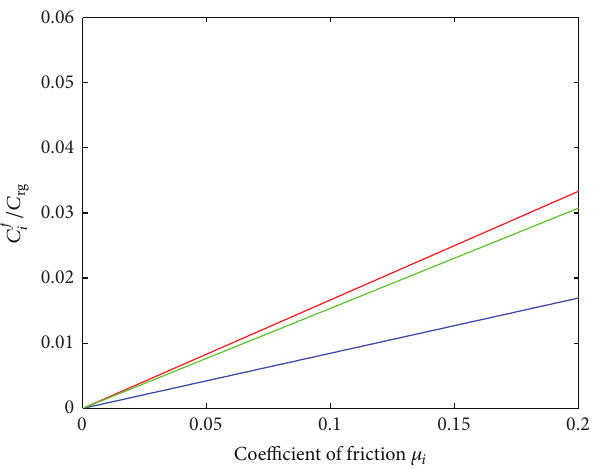
Figure 11: Friction torque ratio 𝐶 𝑖 /𝐶 friction 𝜇 𝑖 with 𝑖 = ( ax / sa , sa / sh , pl / sh ) (while the other parameters were taken to be constant): 𝐶 (red solid line), 𝐶 solid line), 𝐶 line) in a range of variation 𝜇 𝑖 ∈ [0,0.2] .